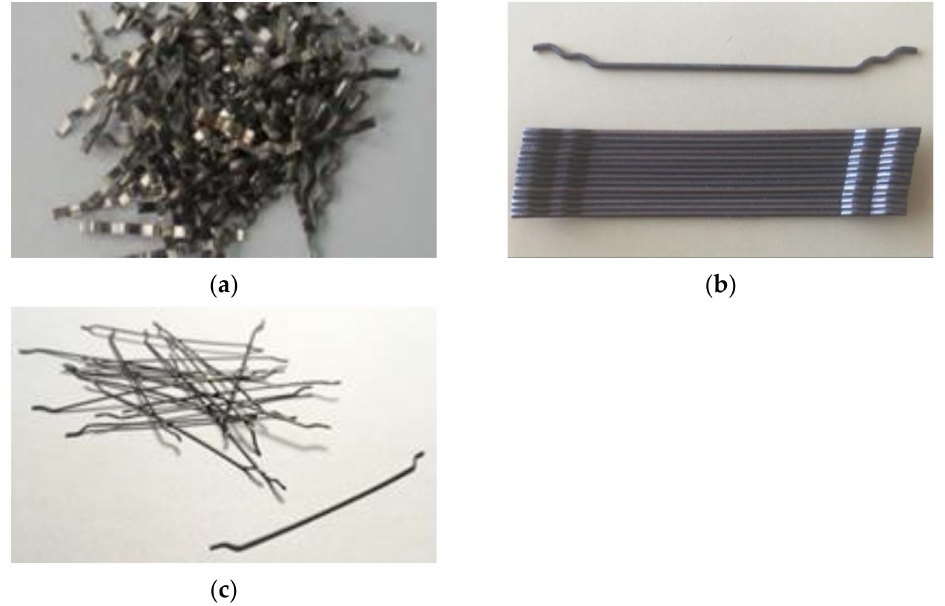
Figure 11. Steel fibers with different appearances: ( a ) Corrugated steel fibers [23]; ( b ) Double hook end steel fibers [24]; ( c ) Single hook end steel fiber